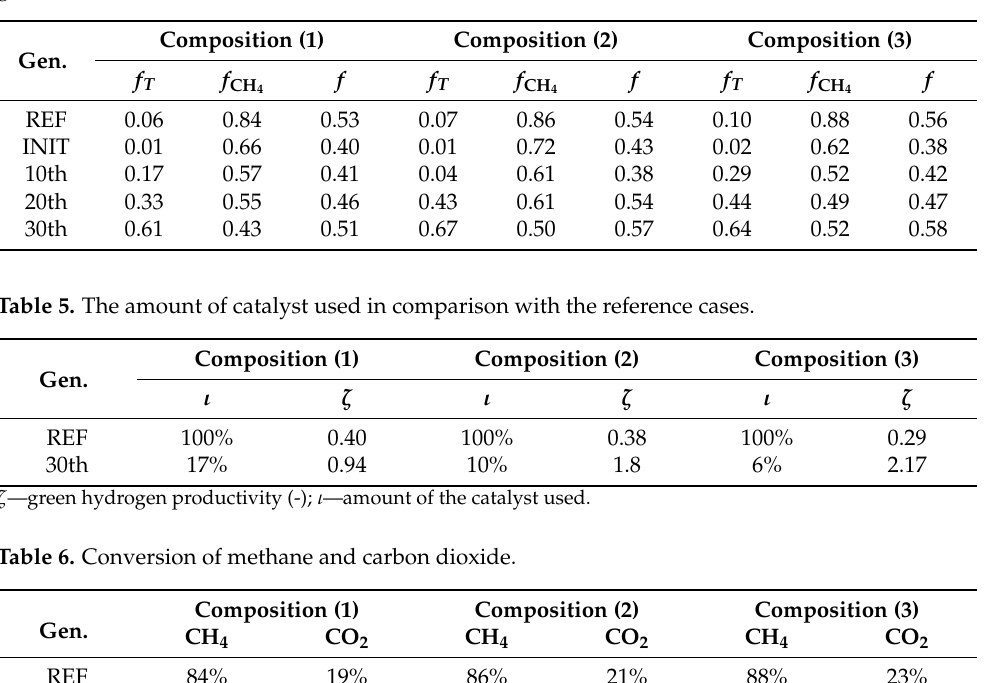
Figure 7. The temperature distribution for biogas composition (3): ( a ) initial, ( b ) 10th gen., ( c ) 20th gen., ( d ) (3) 30th gen. Table 4. Fitness values and conversion acquired for the most optimal specimens in the subsequent generations and for the reference cases.